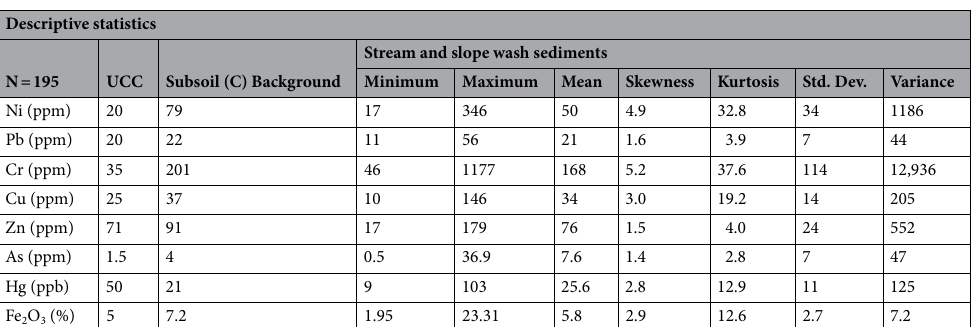
Table 1. Descriptive statistics of the studied heavy metals and their comparisons with upper continental crust (UCC) Taylor and McLennan, (1985) and local background collected from sub soil samples (C) at a depth of 50 cm below ground